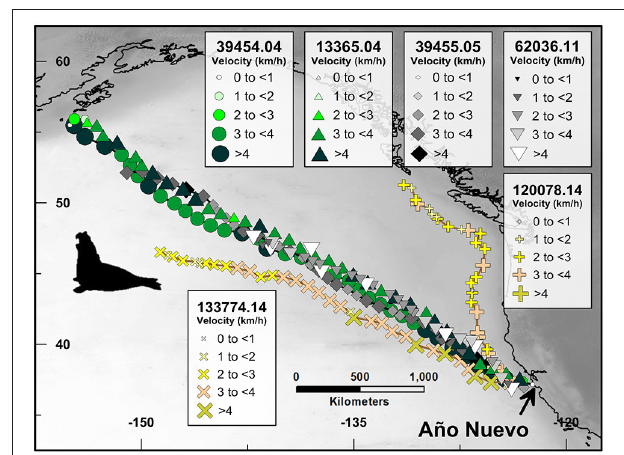
FIGURE 3 | Route fidelity and non-route fidelity movements of satellite-monitored northern elephant seals. Symbol sizes and color hue correspond with average daily track velocity (km/h) as shown in the legends. Unique platform transmitting terminal (PTT) tag numbers to the left of the PTT number decimal point correspond with individual seals and are represented by symbol shape; digits to the right of PTT number decimal point correspond with the abbreviated year in which the whale was tagged and are represented by symbol color family (i.e., green, yellow, black, etc.). Yellow multiplication (PTT 133774.14) and addition (PTT 120078.14) symbols correspond with long-distance non-route fidelity migrations.